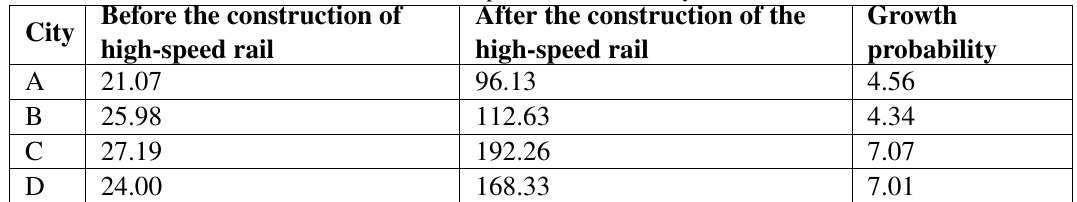
Table 4 Economic potential index analysis